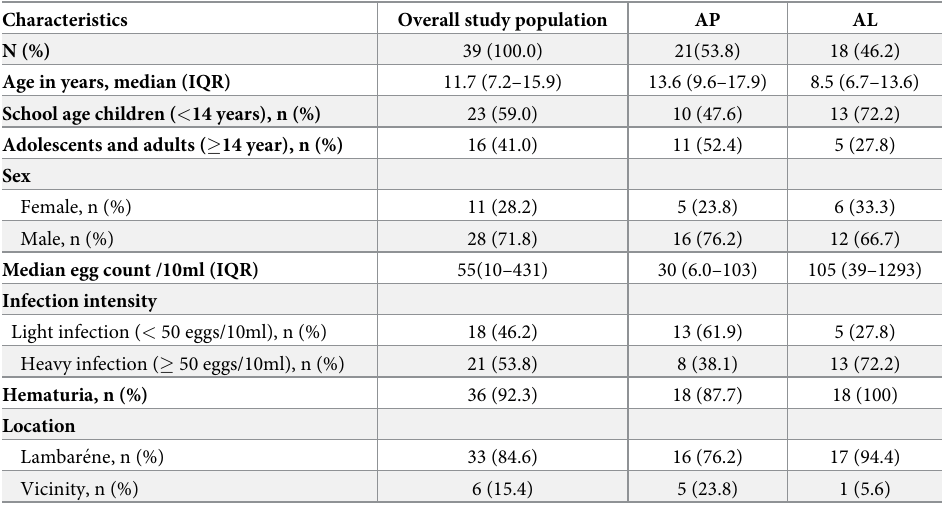
Table 1. Baseline characteristics of study participants treated with artesunate-pyronaridine and artemether-lume- fantrine and included in the analysis, N =